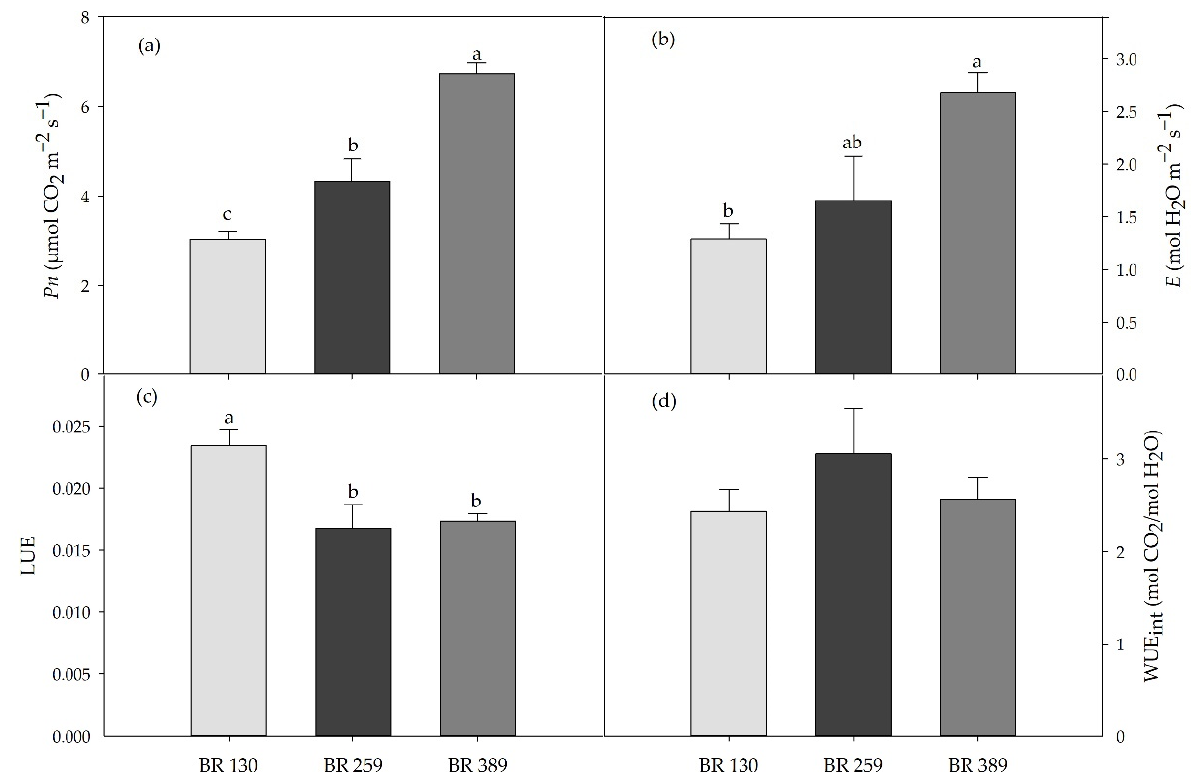
Figure 2. ( a ) Leaf net photosynthesis ( Pn ), ( b ) leaf transpiration ( E ), ( c ) leaf photosynthesis light use efficiency (LUE), and ( d ) intrinsic water use efficiency (WUE int ) in Batavia lettuce cv ‘Blackhawk’ grown under three different light intensities (130, 259, 389 µmol m − 2 s − 1 ). Mean value plus standard errors ( n = 5, 30 DAT). Different letters indicate significant differences at p < 0.5 according to Tuk- ey’s HSD post hoc test.